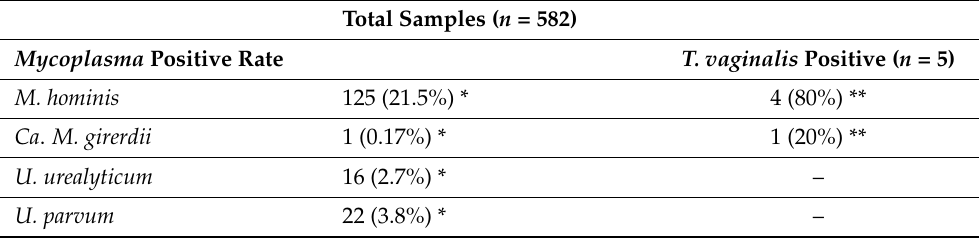
Total Samples ( n =